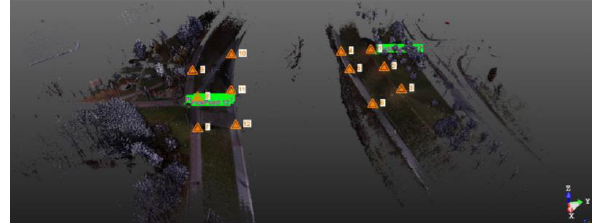
Figure 5. Scanning stations on both embankments (1-12).